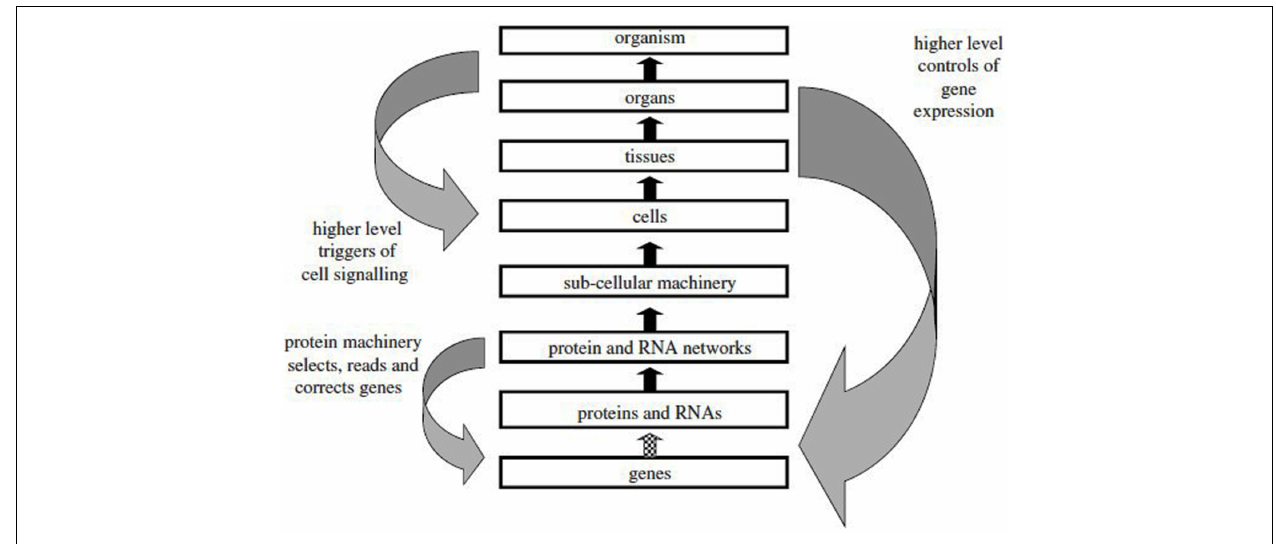
FIGURE 2 |The reductionist upward causal chain from genes to organisms, and various forms of downward causation that regulates lower level components in biological systems. This representation does not take into account the influence of the environment at the various levels (from Noble, 2012, with